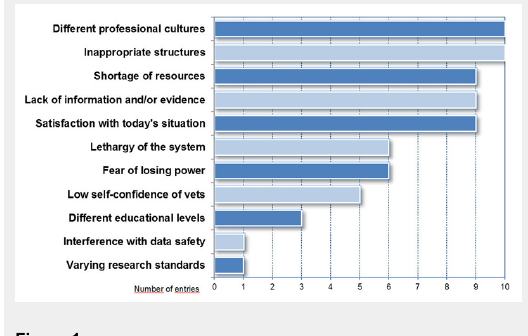
Differentiation of barriers against implementation of One Health in Switzerland (N = 69).